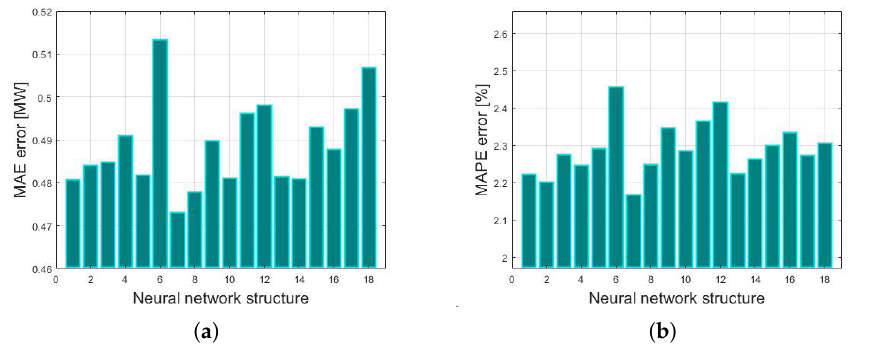
Figure 18. Summary of forecast accuracies by the selected neural network structure for wind power plant FW1. ( a ) MAE. ( b ) MAPE.